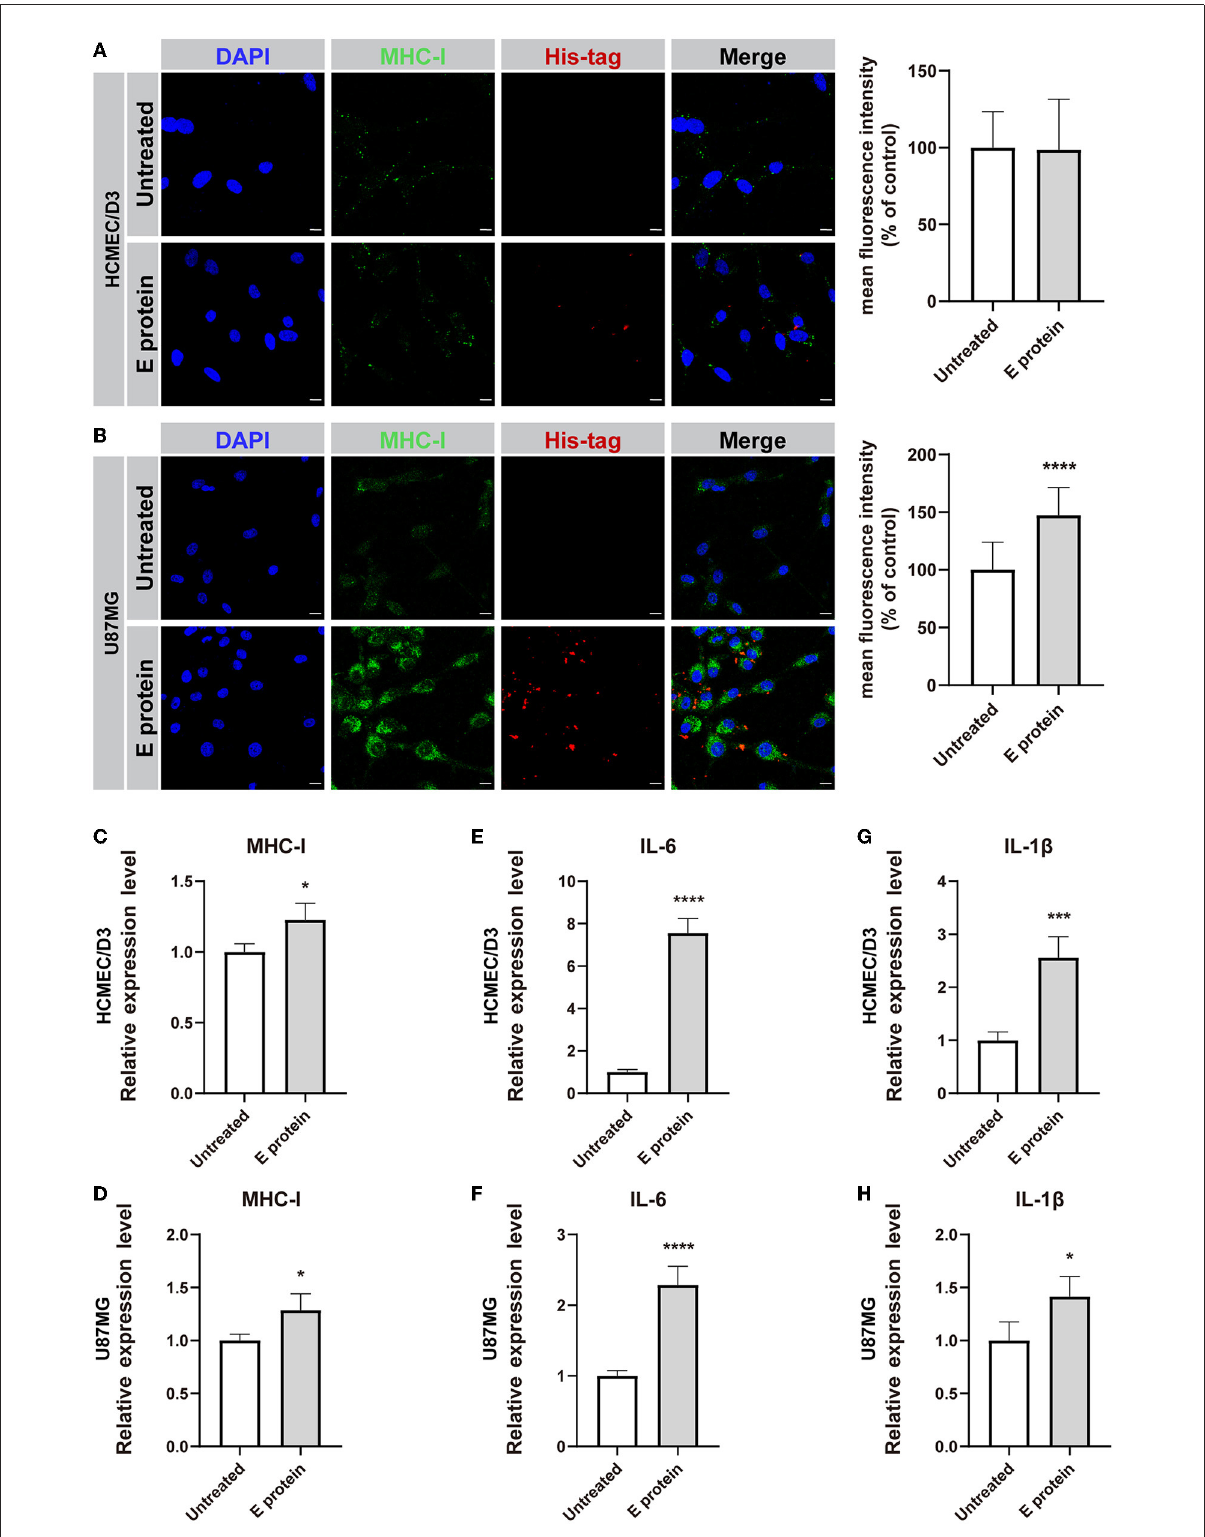
FIGURE4 SARS-CoV-2 envelope protein induces inflammation in HCMEC/D3 and U87MG cells. (A,B) Immunofluorescence staining and semiquantitative analysis of MHC-I. Scale bar = 10 µ m. (C–H) Relative mRNA levels of MHC-I, IL-6 , and IL-1 β , as determined by RT-PCR. The data are shown as the mean ± SD of three independent experiments. * p < 0.05, *** p < 0.001, **** p <